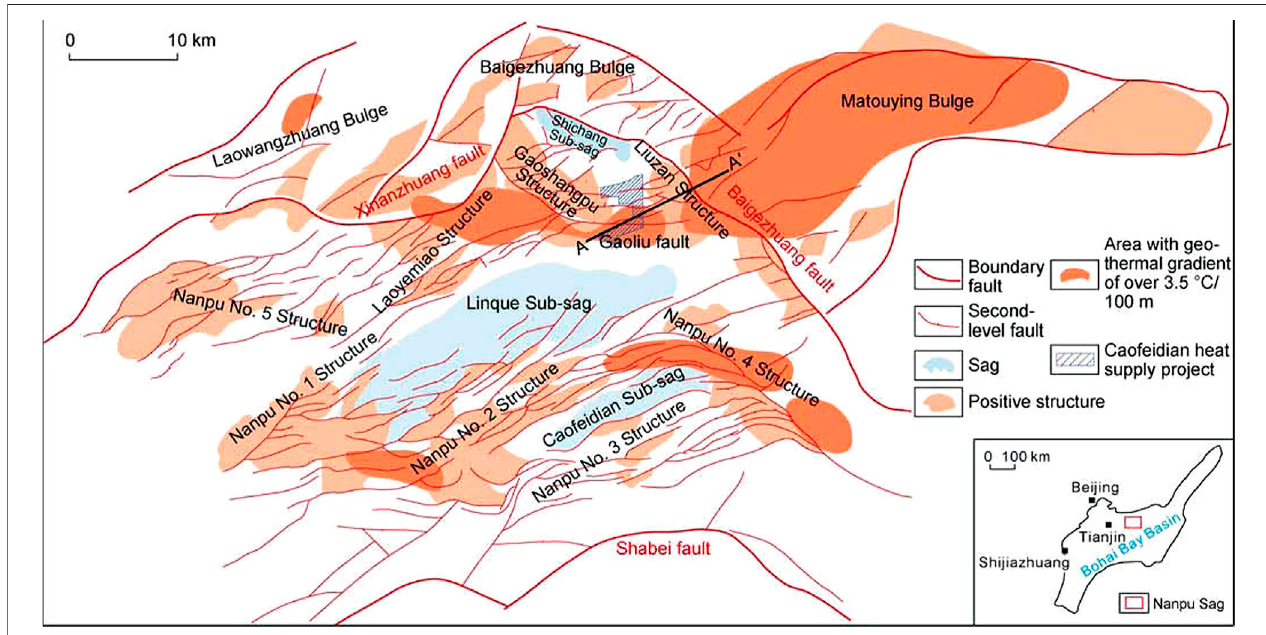
FIGURE 2 | Geological map of the Nanpu Sag and its locations in Bohai Bay Basin (cited from Dong et al., 2021).